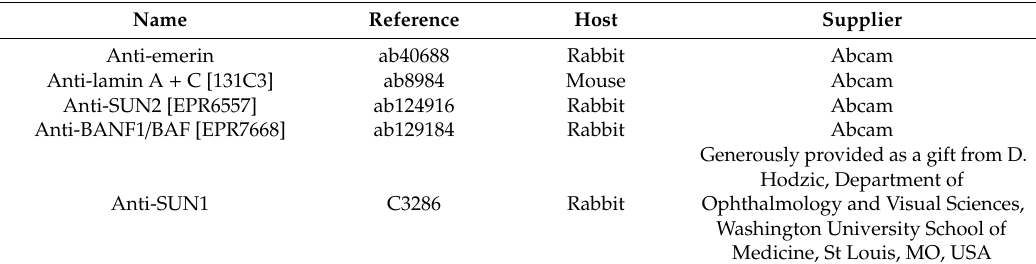
Table 1. List of antibodies used in this